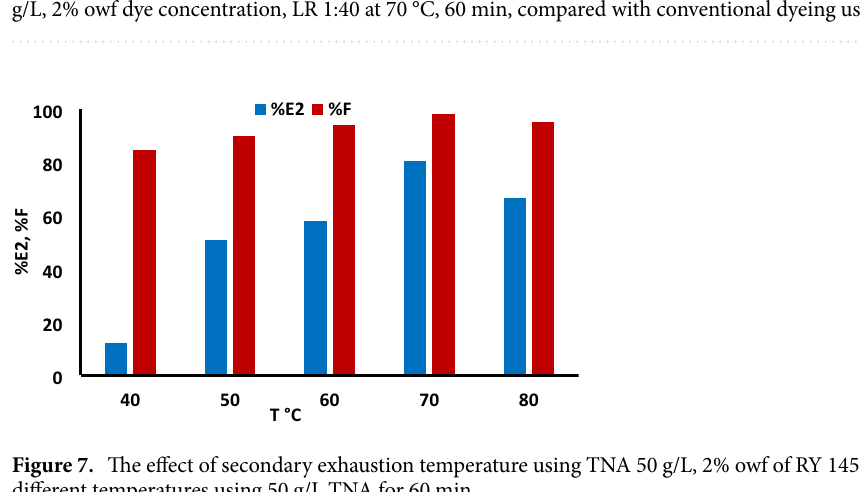
Figure 7. The effect of secondary exhaustion temperature using TNA 50 g/L, 2% owf of RY 145 dye, LR 1:40 at different temperatures using 50 g/L TNA for 60 min.